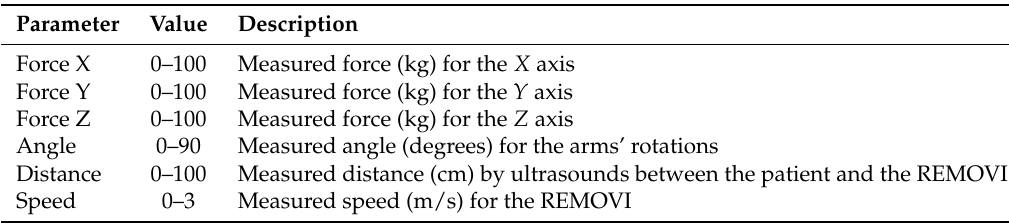
Table 11. REMOVI to PC data frame